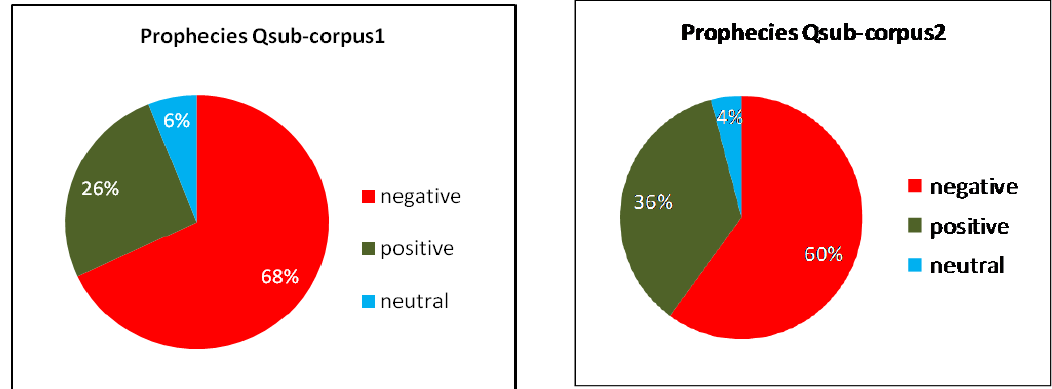
Figure 8. Positive and negative connotations comparing two datasets of Quaker prophetic writings.